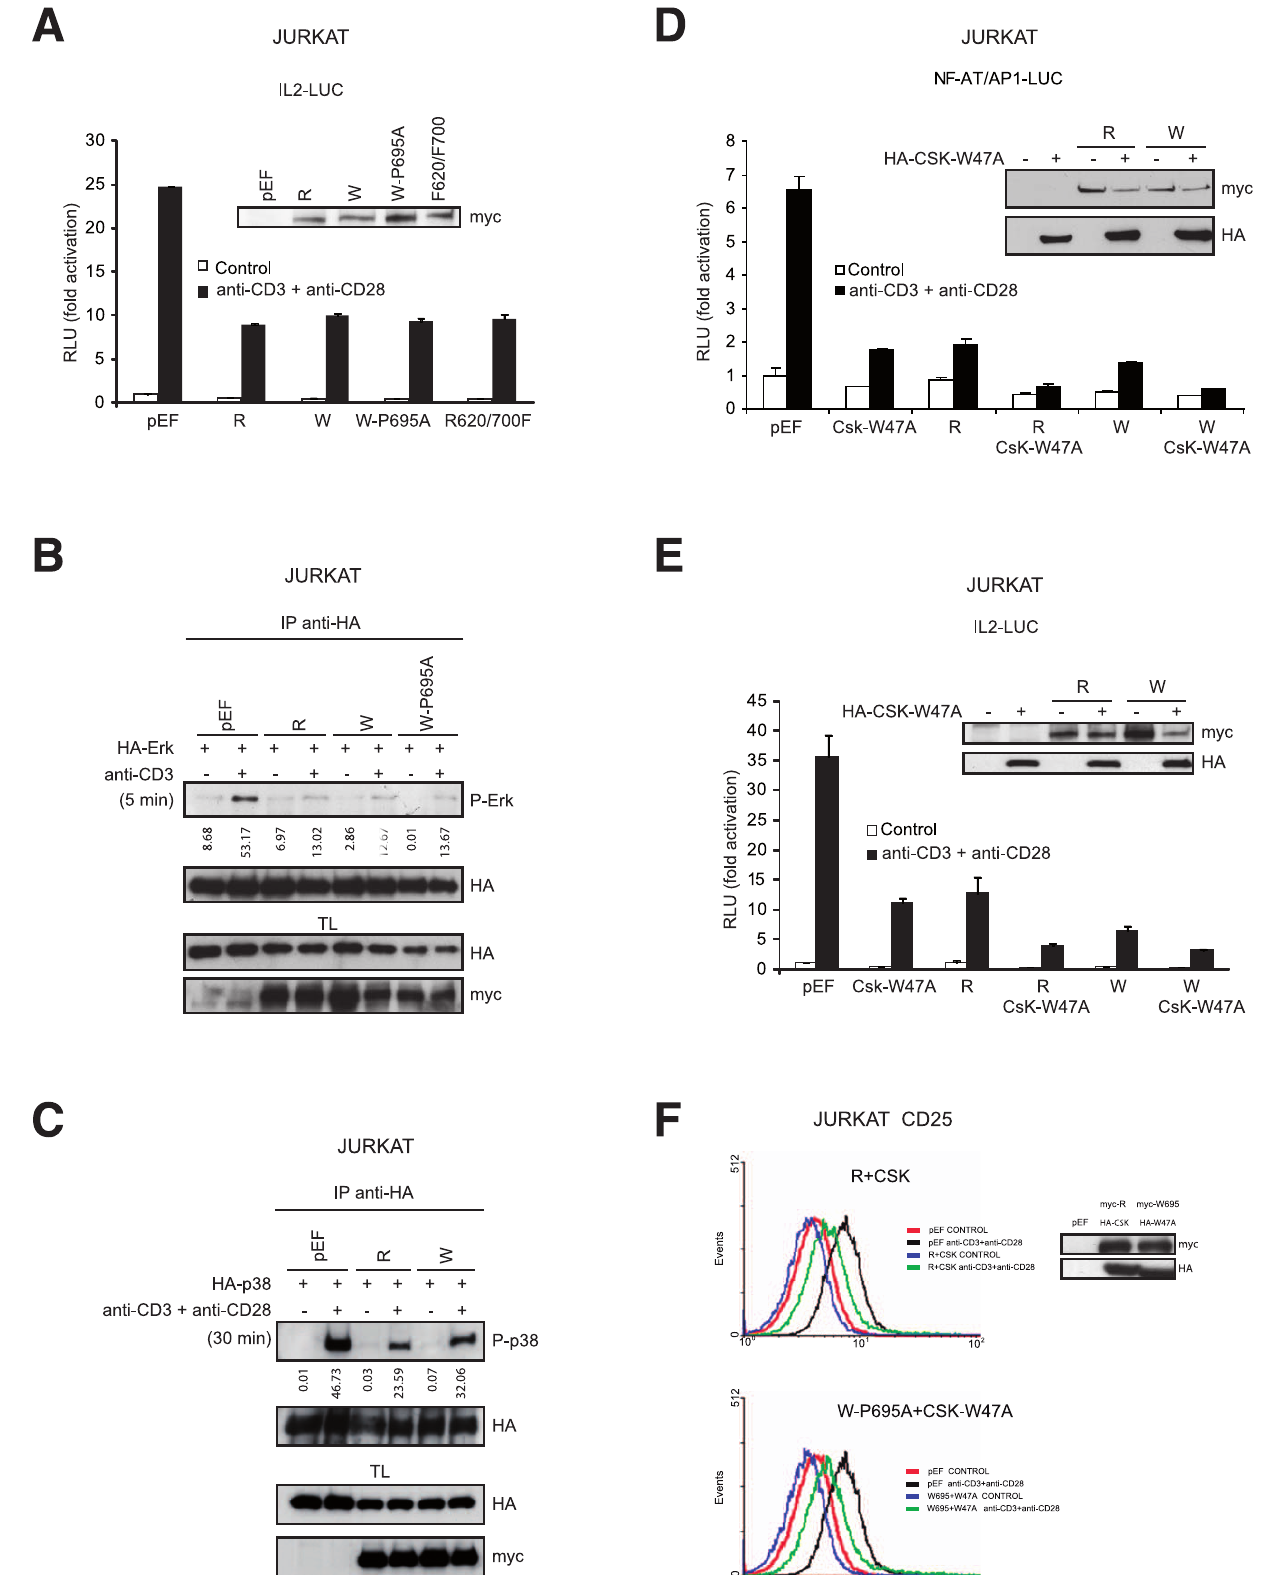
Figure 4. LYP/CSK interaction is not required to regulate TCR signaling. A , Activation of a luciferase reporter gene driven by the IL-2 minimal promoter in Jurkat cells co-transfected with different myc-LYP plasmids, as indicated. The insert shows the expression of the LYP proteins as detected by IB. B , Erk activation was assayed in Jurkat cells transfected with different versions of LYP, as indicated, and stimulated with anti-CD3 Ab